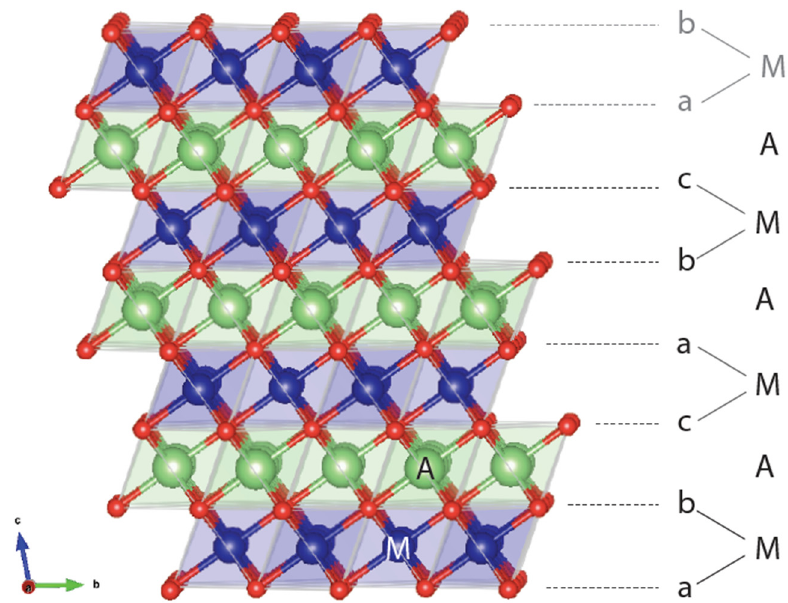
Figure 1. Representative O3 structure showing the abc stacking sequence of oxygen ions (red), thus creating various coordination environments for the alkali ion A (green) and metal ion M (blue). In an O3 repeat unit, M and A are coordinated below and above by oxygen layers. The beginning of another repeat unit with a-M-b stacking is in gray.